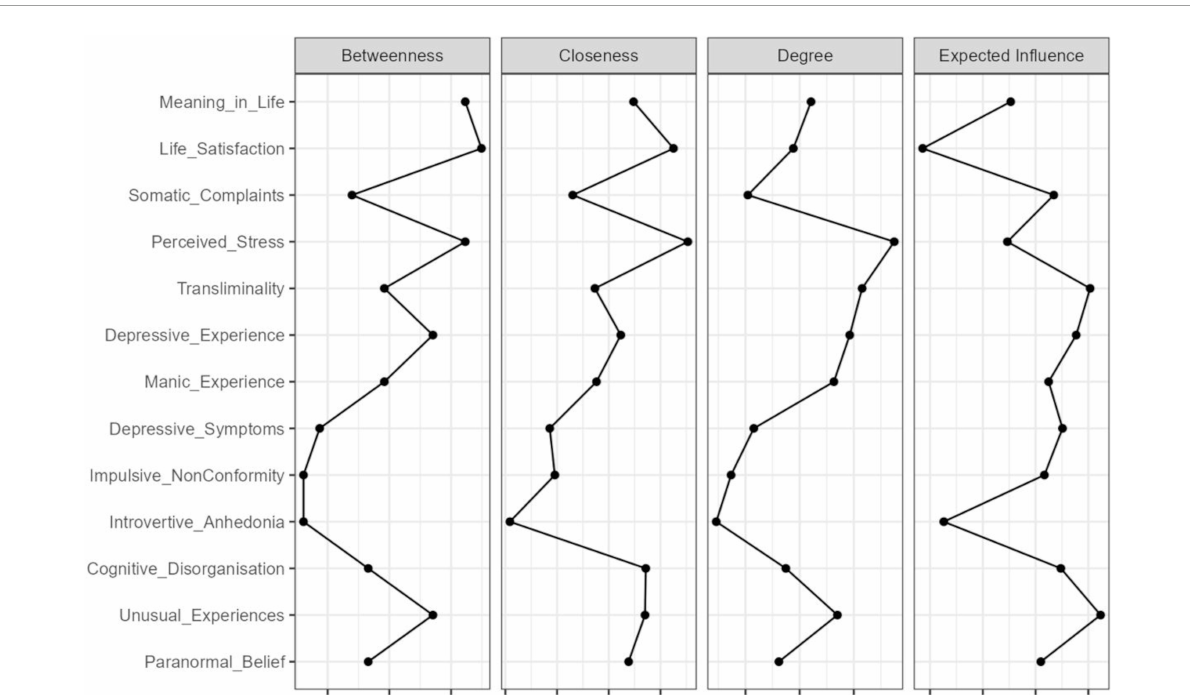
FIGURE2 Centrality plots for EBICglasso network depicting the betweenness, closeness, degree (strength), and expected influence of each node